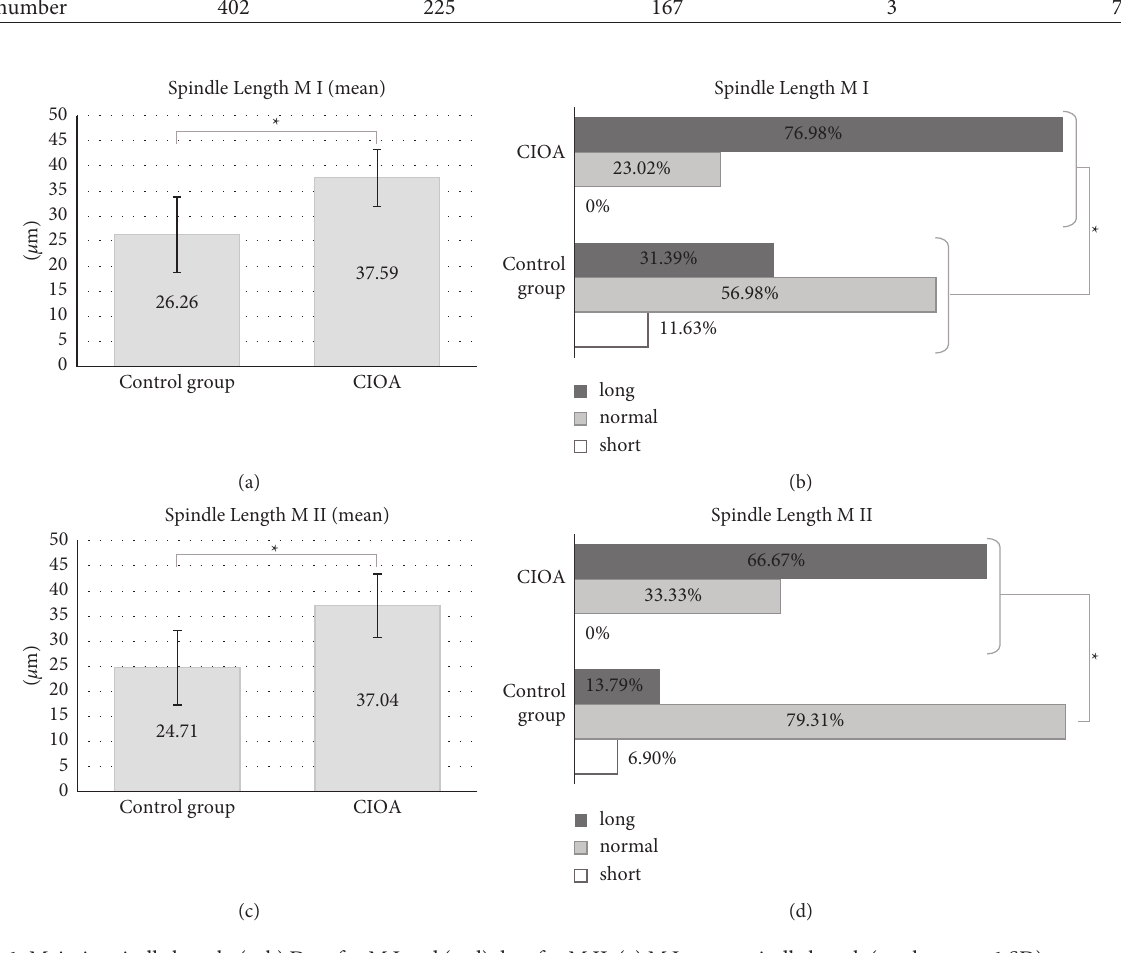
Figure 1: Meiotic spindle length. (a, b) Data for M I and (c, d) data for M II. (a) M I mean spindle length (total mean ± 1 SD), comparison of controls (26.26 ± 7.52 μ m, n � 86) and CIOA (37.59 ± 5.63 μ m, n � 139); independent samples t -test, ∗ p < 0 . 001. (b) Distribution of M I spindle length categories in %. “Normal” range (mean ± 1 SD) from the control group. Control group ( n � 86): short ( n � 13), normal (26.26 ± 7.52 μ m, n � 60), long ( n � 13); CIOA ( n � 139): normal (26.26 ± 7.52 μ m, n � 50), long ( n � 89); Fisher–Freeman–Halton Exact Test, ∗ p < 0 . 001. (c) M II mean spindle length (total mean ± 1 SD), comparison of controls (24.72 ± 7.46 μ m, n � 116) and CIOA (37.04 ± 6.38 μ